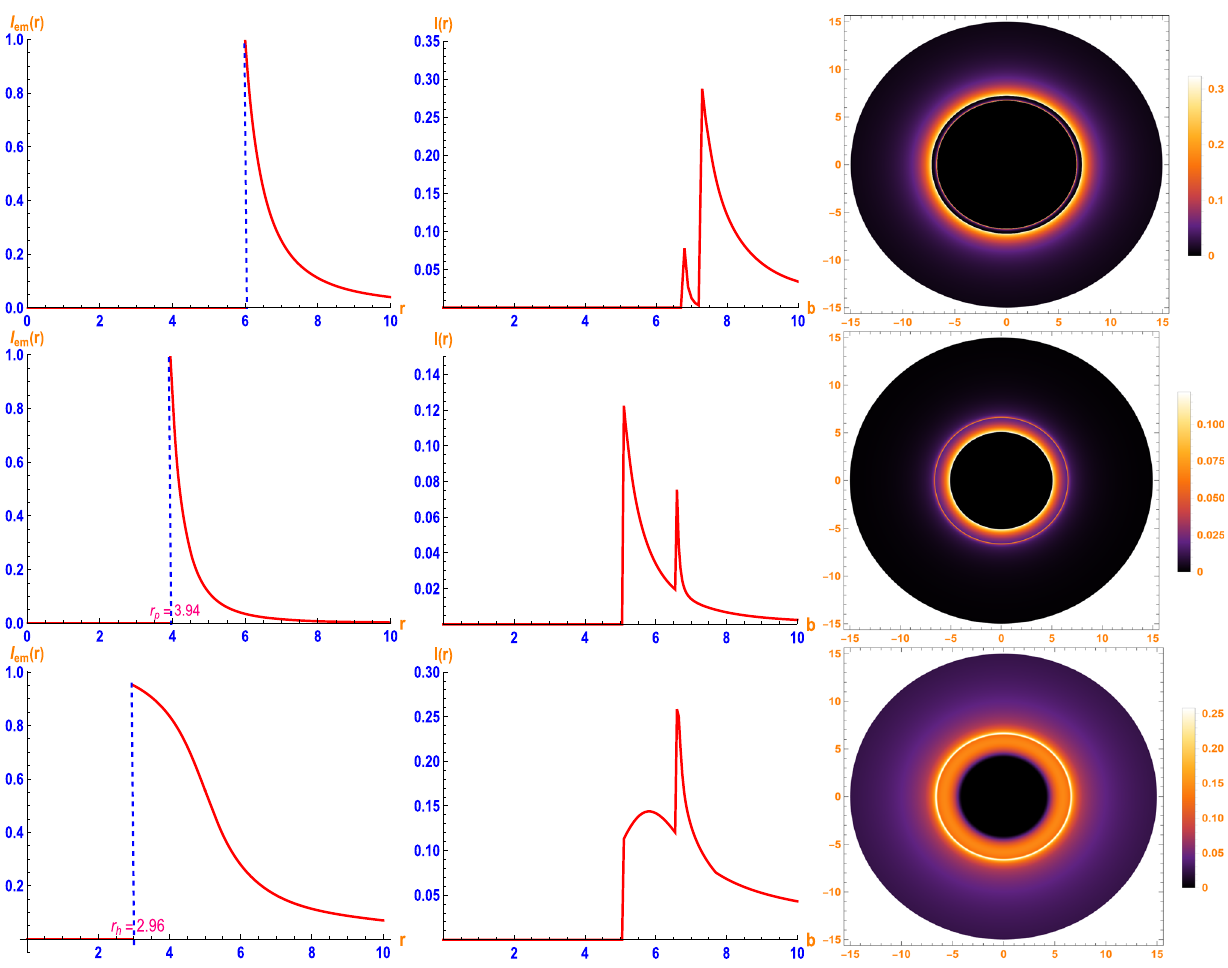
Fig. 6 Optical observation of thin disk accretion near the BH with different emission matter profiles, viewed from a face-on orientation. From left to right panels, the depicted graphs are reflecting the various